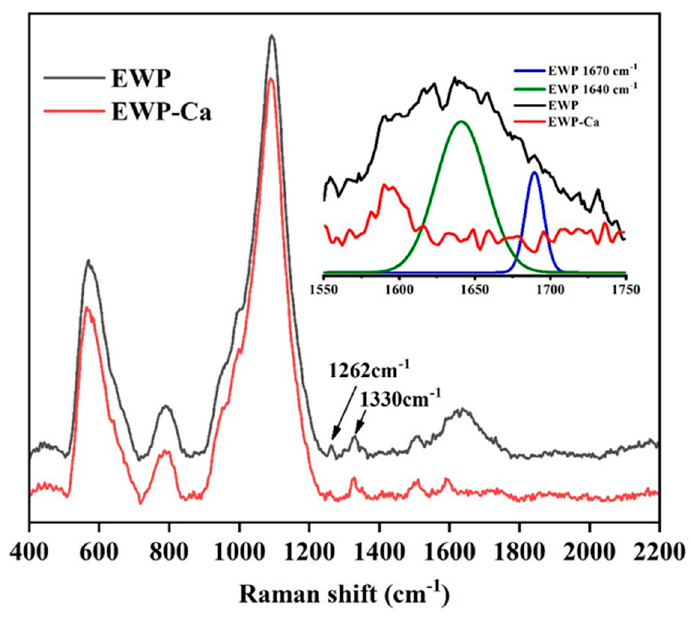
Figure 4. Raman spectra of EWP and EWP-Ca from 600 to 2200 cm − 1 .